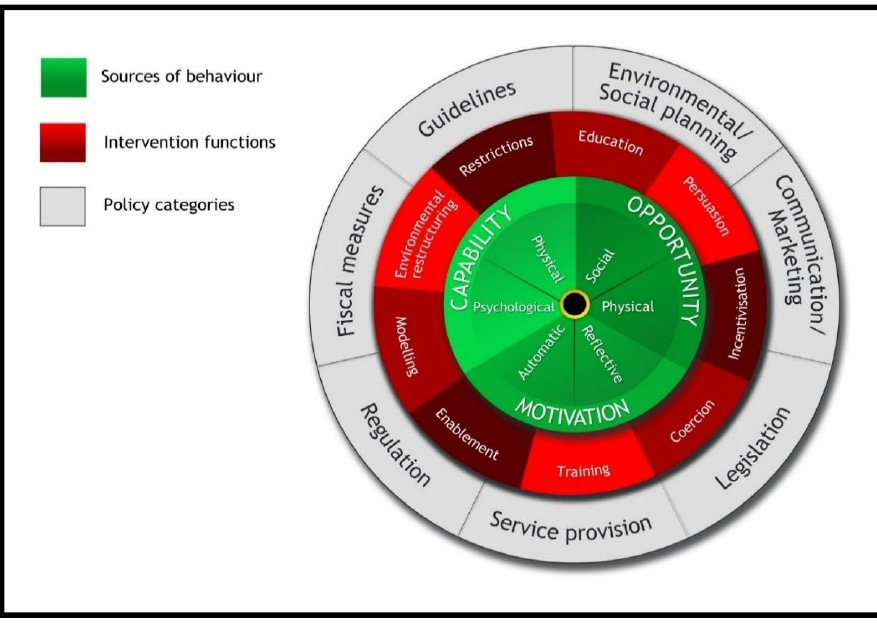
Figure 1. The Behaviour Change Wheel [29].